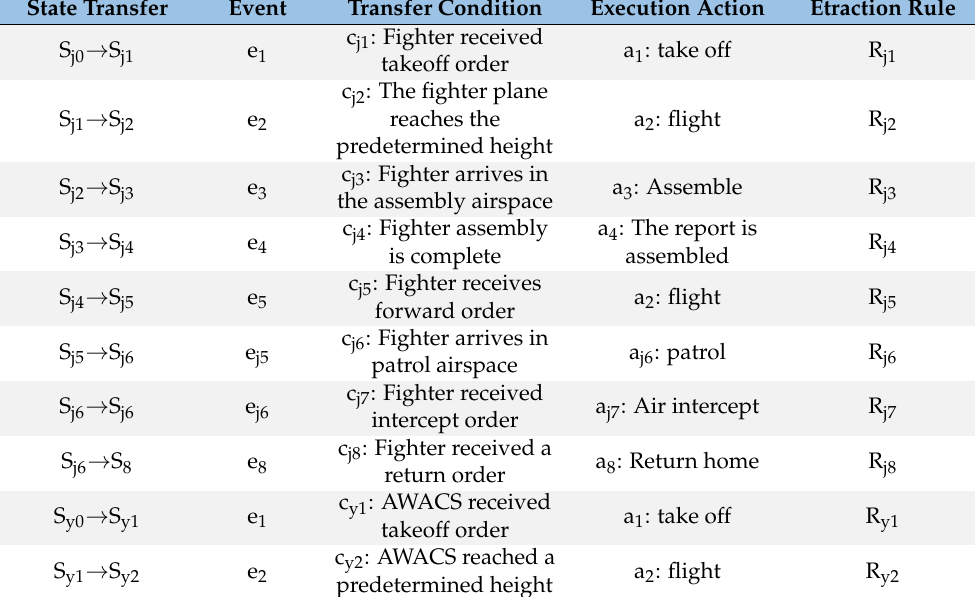
Table 3. Changes in the state of air and sea jointed anti-sea assaults in naval